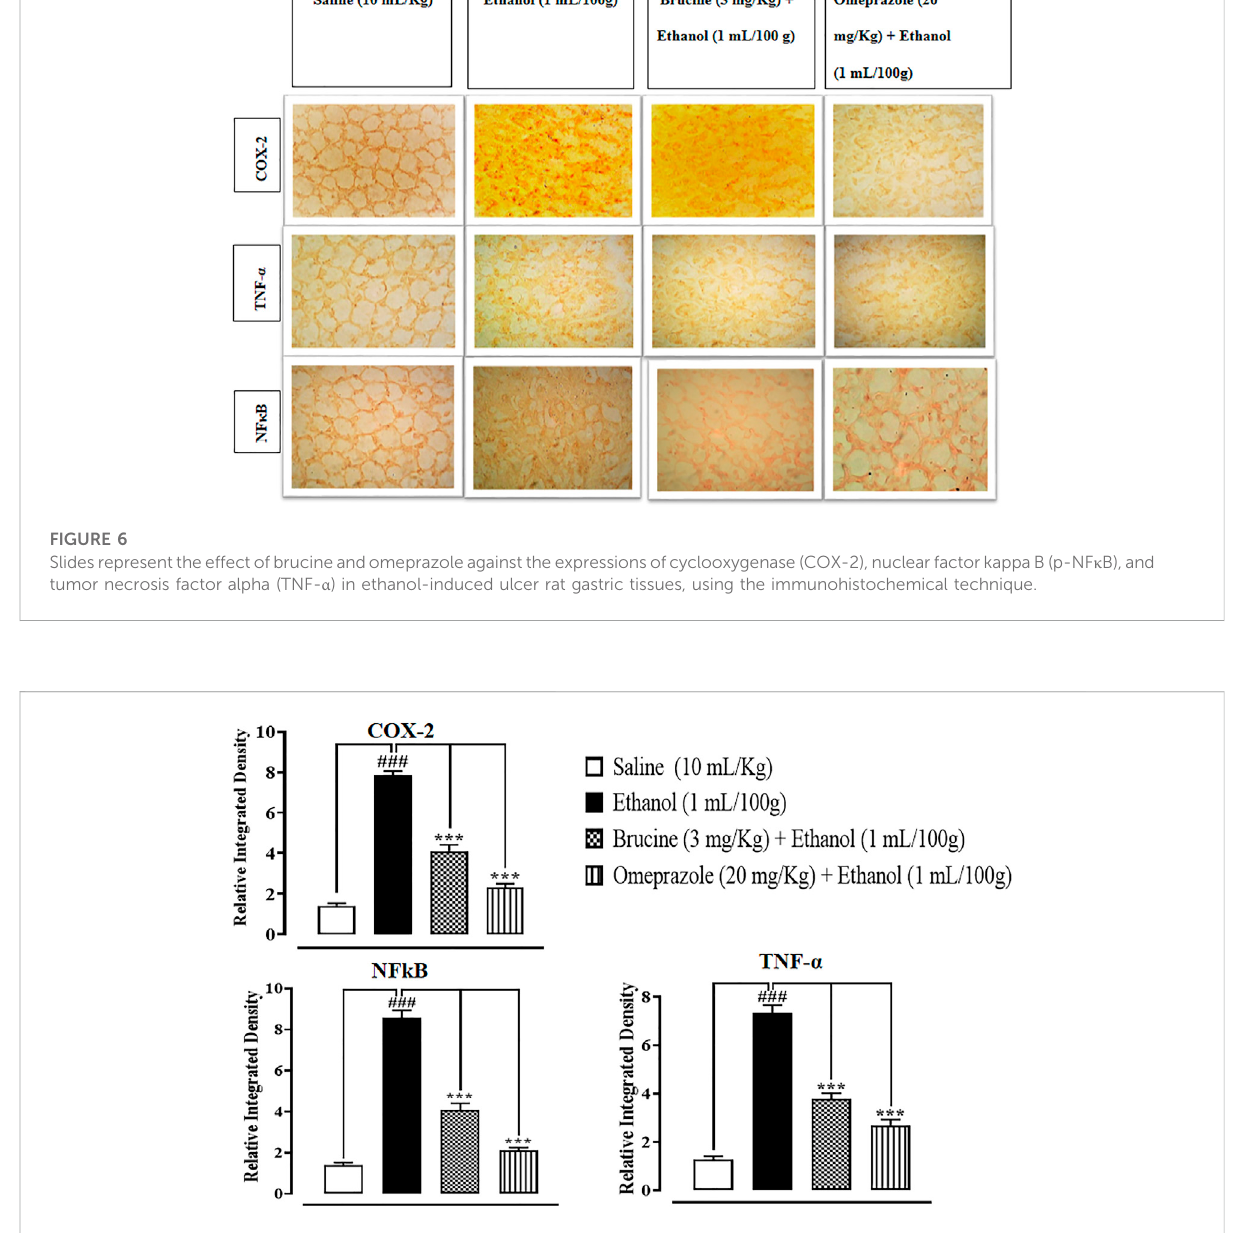
FIGURE 7 Effects of brucine and omeprazole against cyclooxygenase (COX-2), nuclear factor kappa B (p-NF κ B), and tumor necrosis factor alpha (TNF- α ) inethanol-inducedulcerratgastrictissues,usingtheimmunohistochemicaltechnique.Valuesexpressedasmean±SEM( n =5).Datawereanalyzed by one-way ANOVA, followed by post hoc Tukey ’ s test. ### p < 0.001 vs. saline group. ppp p < 0.001 vs. ethanol